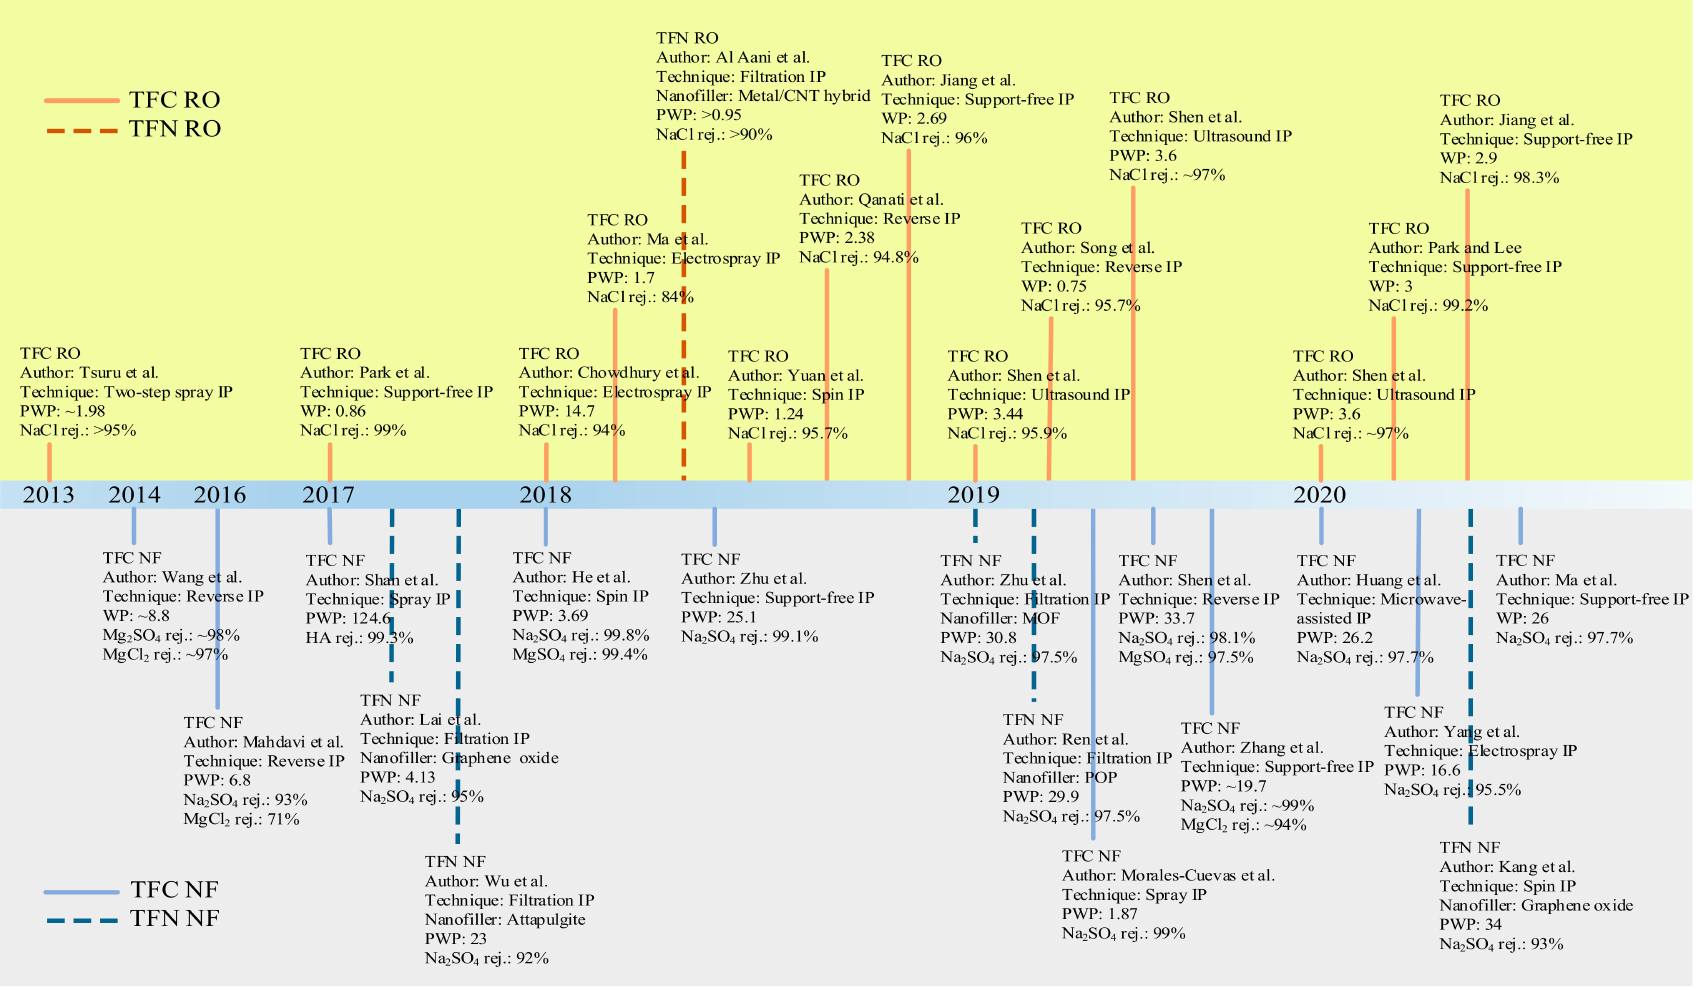
Figure 4. Chronological development of novel IP techniques for pressure-driven water-treatment processes. Permeability is in L / m 2 · h · bar